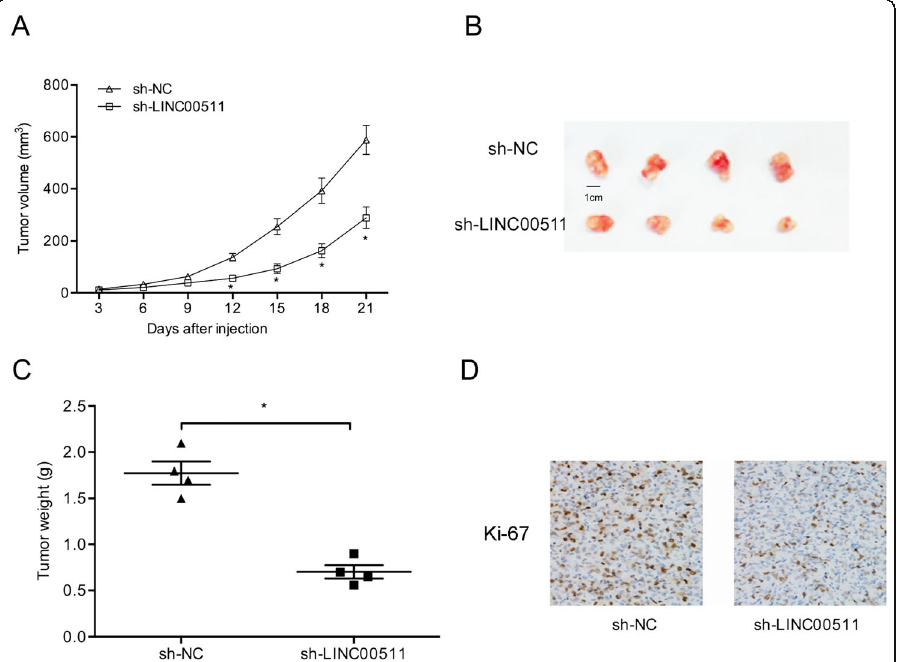
Fig. 5 Downregulation of LINC00511 reduces tumor growth. a - c through Tumor volume growth curves and weights for the sh-LINC00511 group showed inhibition compared to the sh-NC group. d Ki67 expression was reduced in sh-LINC00511-treated nude mice. * p <